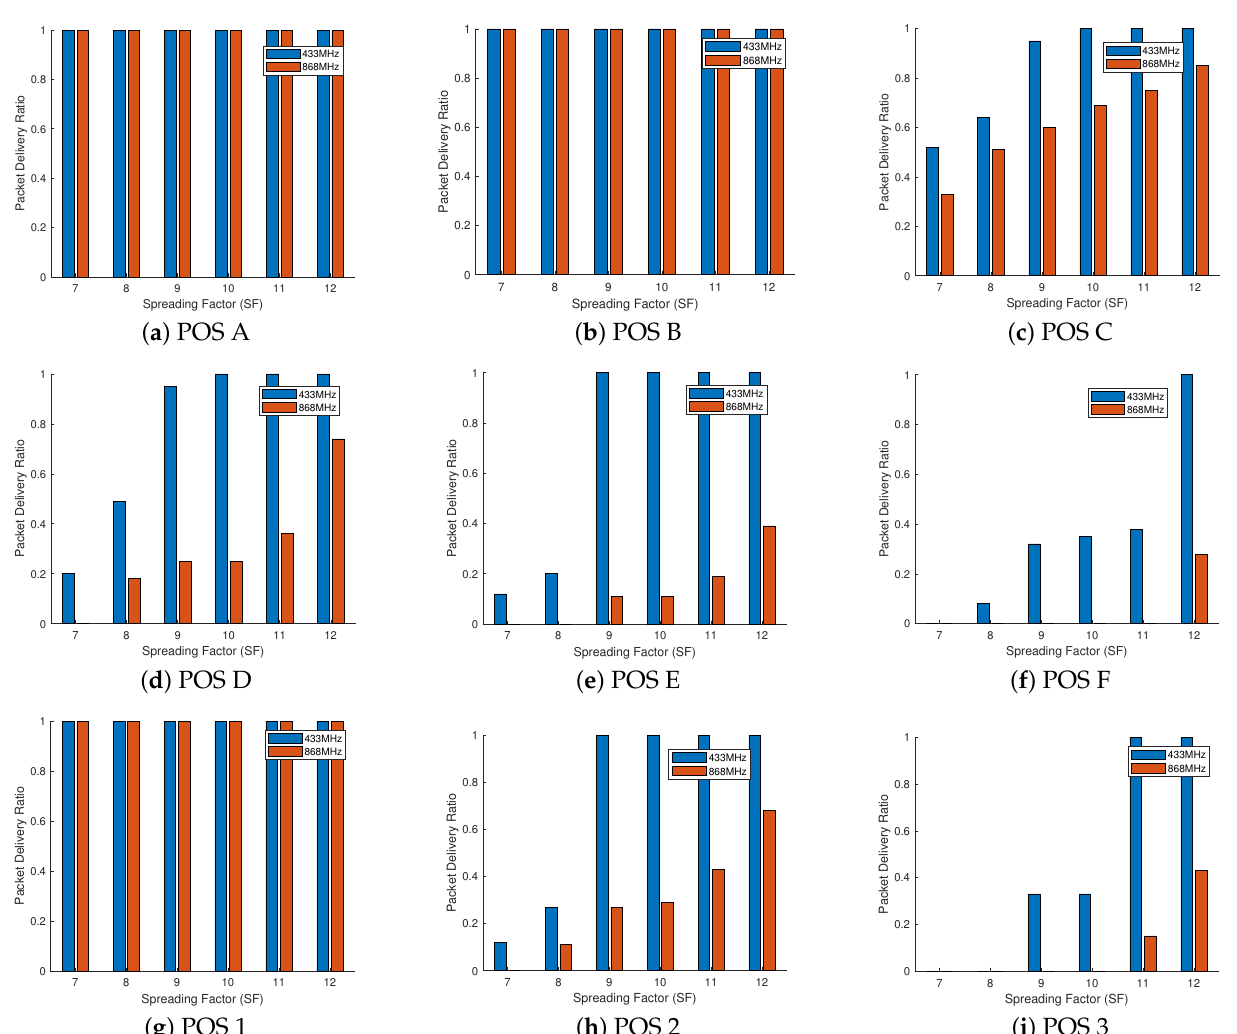
Figure 15. PDR achieved for transmissions from all positions for different SF values, with CR = 4/5, BW = 125 KHz in the 433 MHz and 868 MHz frequency